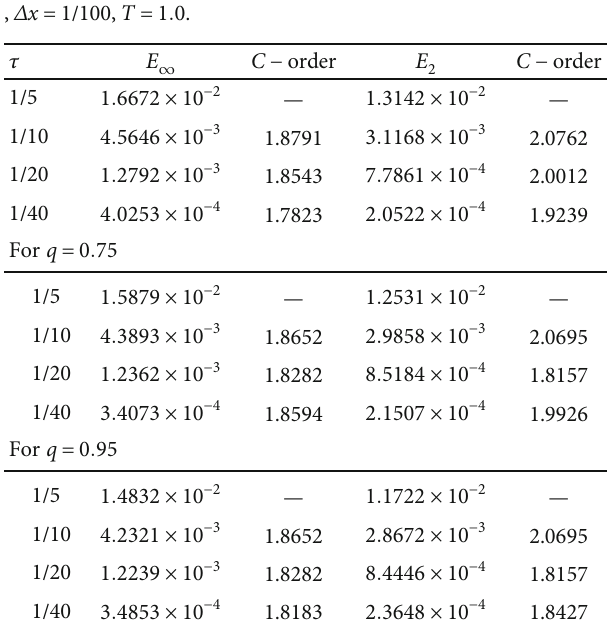
Table 3: Order of convergence of the IDS for Example 6 at q = 0 : 5 , Δ x = 1/100, T = 1 : 0 .